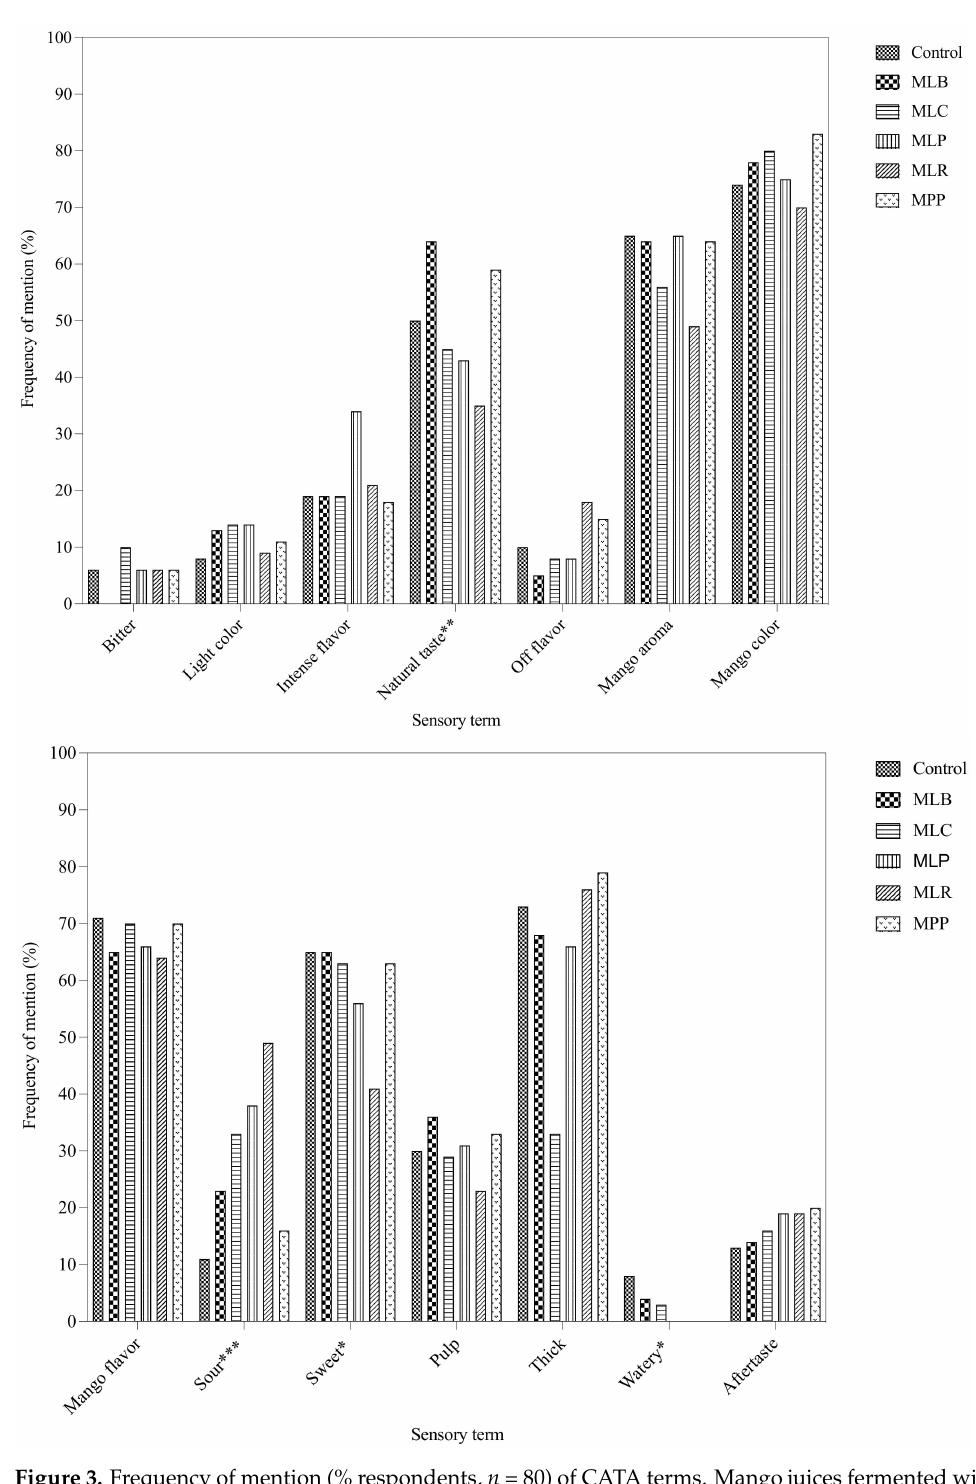
Figure 3. Frequency of mention (% respondents, n = 80) of CATA terms. Mango juices fermented with MLB— Levilactobacillus brevis ; MLC— Lacticaseibacillus casei ; MLP— Lactiplantibacillus plantarum subsp. plantarum ; MLR— Lacticaseibacillus rhamnosus ; MPP— Pediococcus pentosaceus . Control is mango juice with no lactic acid bacteria under the same conditions of fermentation (24 h). Significant differences * p < 0.05, ** p < 0.01, *** p < 0.001 using Cochran’s Q